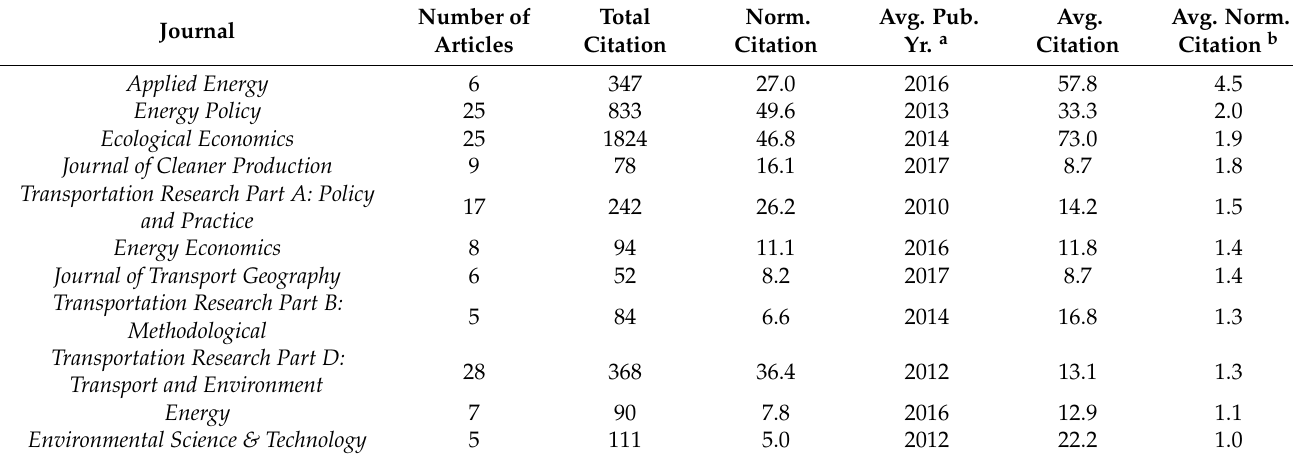
Table 1. Quantitative summary of journal impacts in infrastructure externalities research.